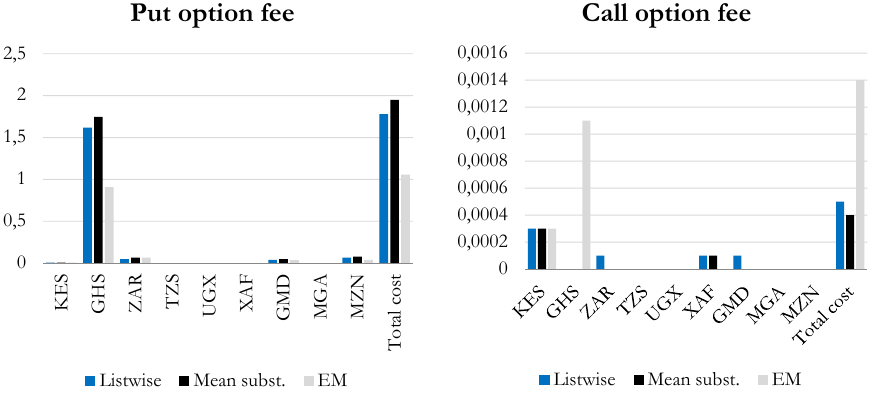
Fig. 2 – Cost of a selective hedging strategy (against USD). Source: author’s